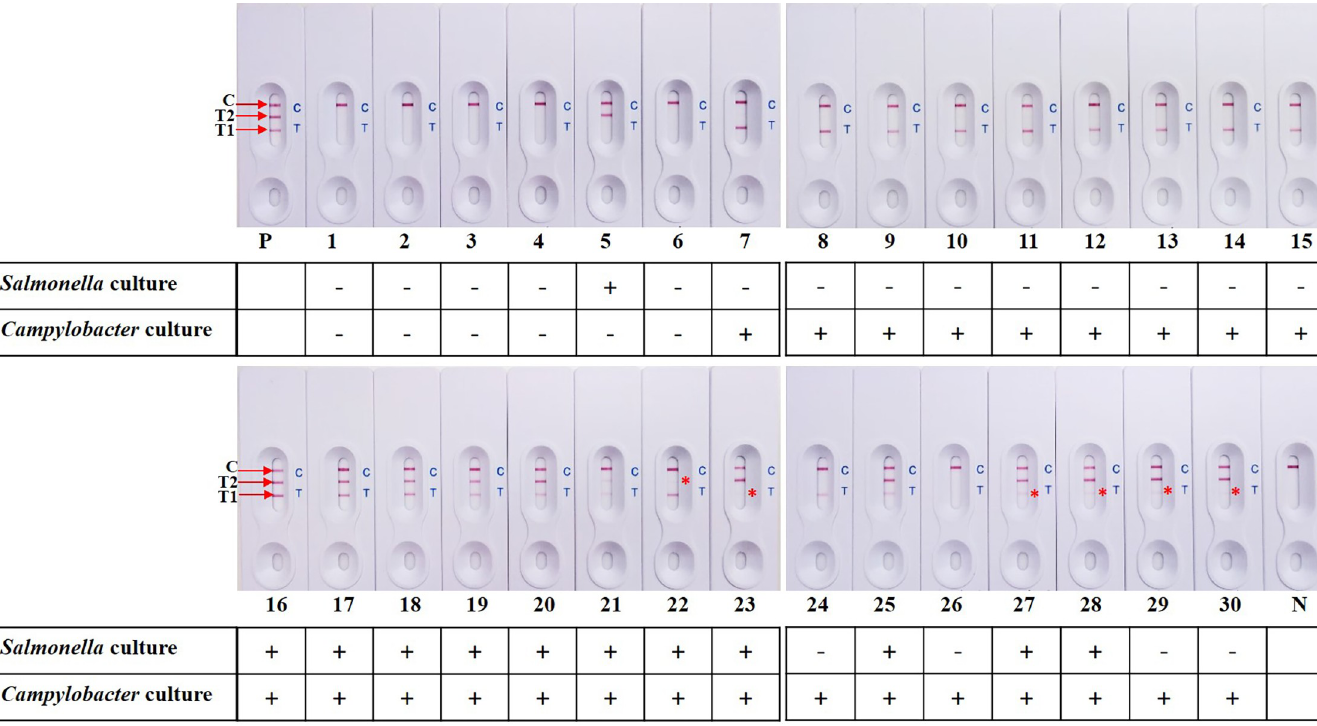
Fig 6. Evaluation of d-LAMP-LFB by detecting of Salmonella spp. and Campylobacter spp. in naturally contaminated raw chicken meat samples. LFB: 1–30 obtained from retail markets; LFB 26 showed false-negative result for Campylobacter spp.; LFB 29 and 30 showed false-positive result for Salmonella spp.; P: positive control ( C . jejuni DMST 15190 + S . Typhimurium ATCC 23566); N: blank control; � Indicated weakly positive signals; “+”: the culture test result is positive; “-”: the culture test result is negative.